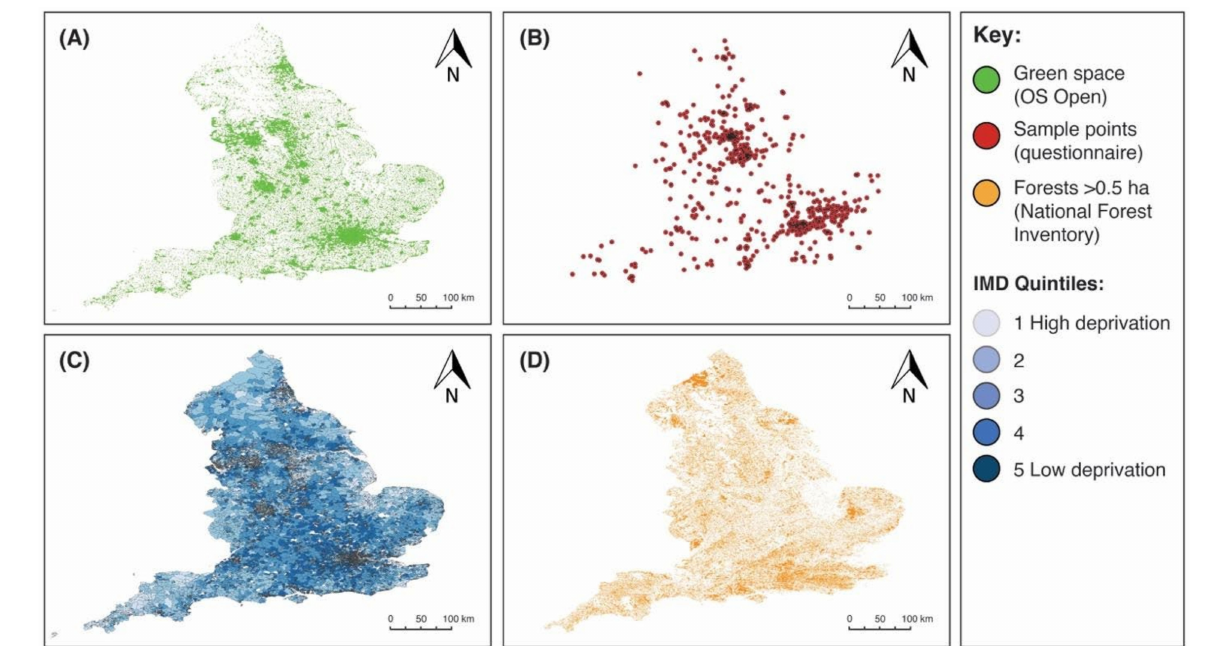
Figure 2. Spatial outputs combined with England boundary datasets. ( A ) shows the distribution of OS Open Green Space polygons; ( B ) shows the distribution of georeferenced samples from the survey; ( C ) shows the Lower Super Output Areas with joined index of multiple deprivation quintile data, whereby 1 corresponds to relatively high deprivation (and lighter blue) and 5 corresponds to relatively low deprivation (and darker blue); and ( D ) shows distribution of forests > 0.5 ha. Table 1. Patterns of change in visits/exposure to natural environments as a result of the COVID-19 pandemic. Response No. of